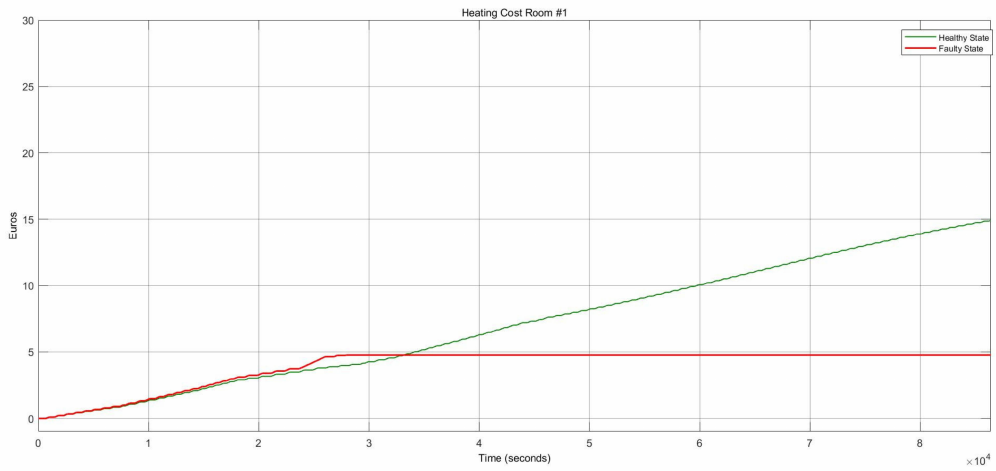
Figure 16. Heating cost variations for the damper actuator and temperature sensor faults. Multiple Fault Injection in One Component (Intermittent Fault in Heater Actuator with 10